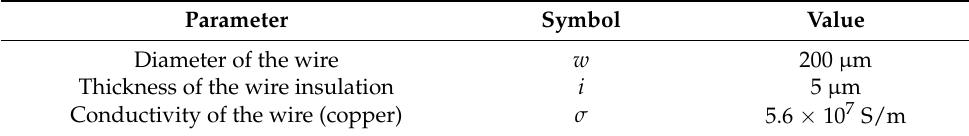
Table 3. Parameters of the wire used to form the coils.